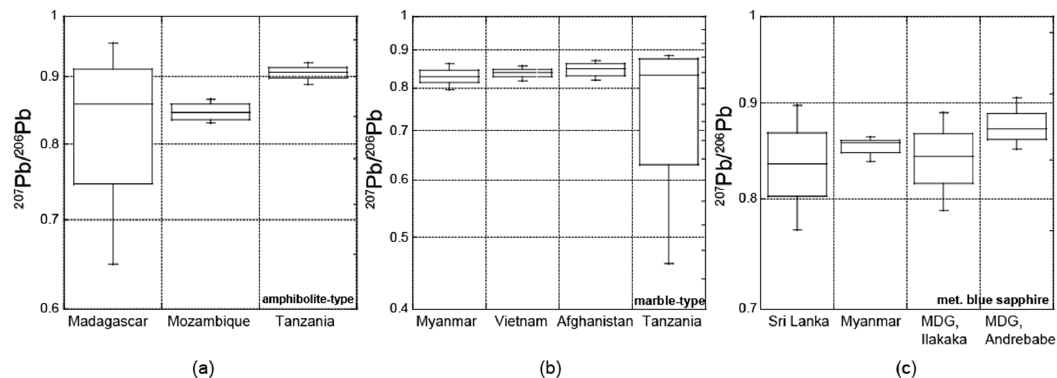
Figure 9. Box and whisker plots displaying 207 Pb / 206 Pb isotopic compositions of gem corundum from ( a ) the amphibolite-type ruby localities, ( b ) the marble-type ruby localities, and ( c ) the localities of metamorphic blue sapphire measured in this study.